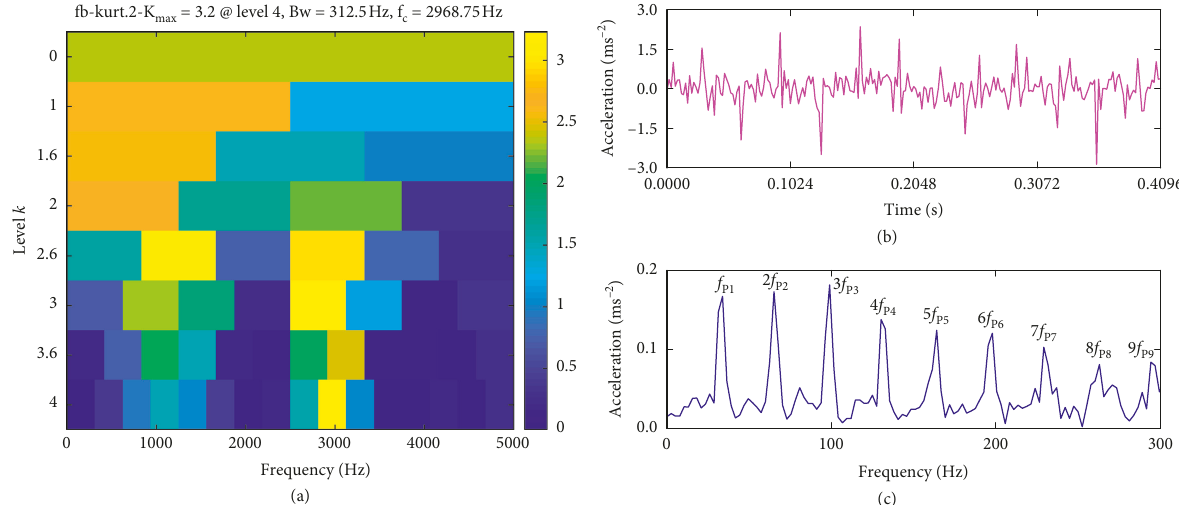
Figure 19: Processing results obtained using spectra kurtosis: (a) fast kurtogram; (b) purified signal; (c) Hilbert envelope spectra.